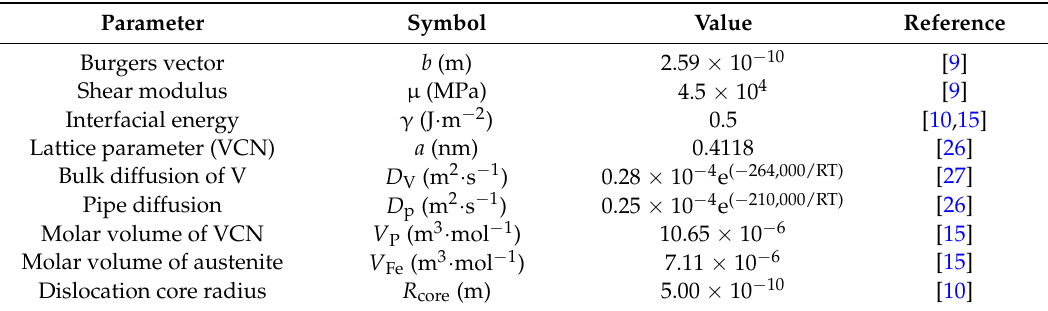
Table 2. Parameters used for